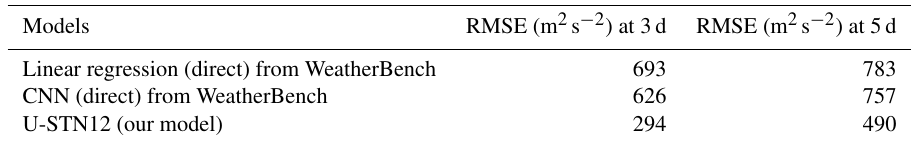
Table A1. Comparison of U-STN12 with two WeatherBench models.